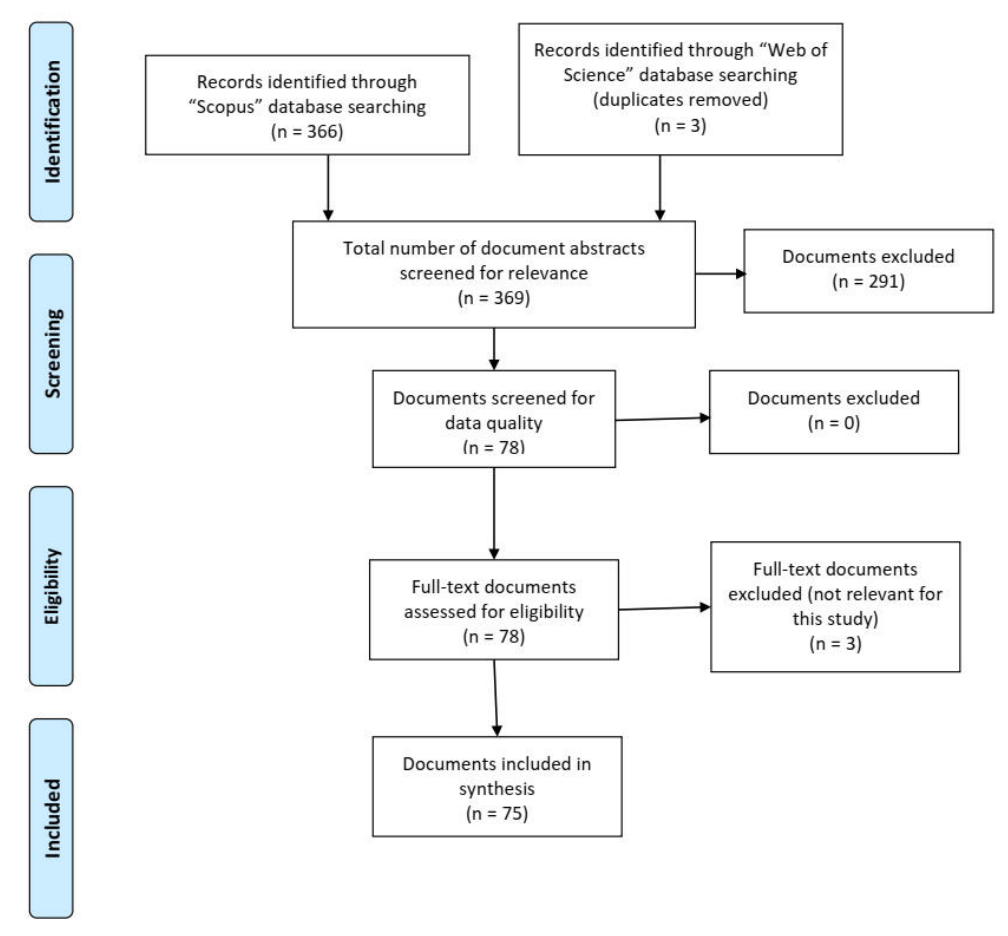
Figure1. PreferredReportingItemsforSystematicReviewandMeta-Analysis(PRISMA)flowdiagram[53]. Figure 1. Preferred Reporting Items for Systematic Review and Meta-Analysis (PRISMA) flow diagram [53].